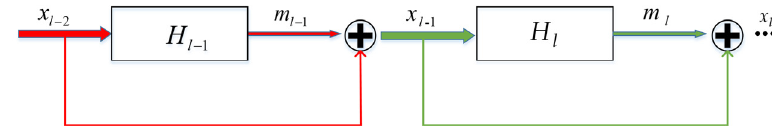
Figure 1. The structure of residual learning.